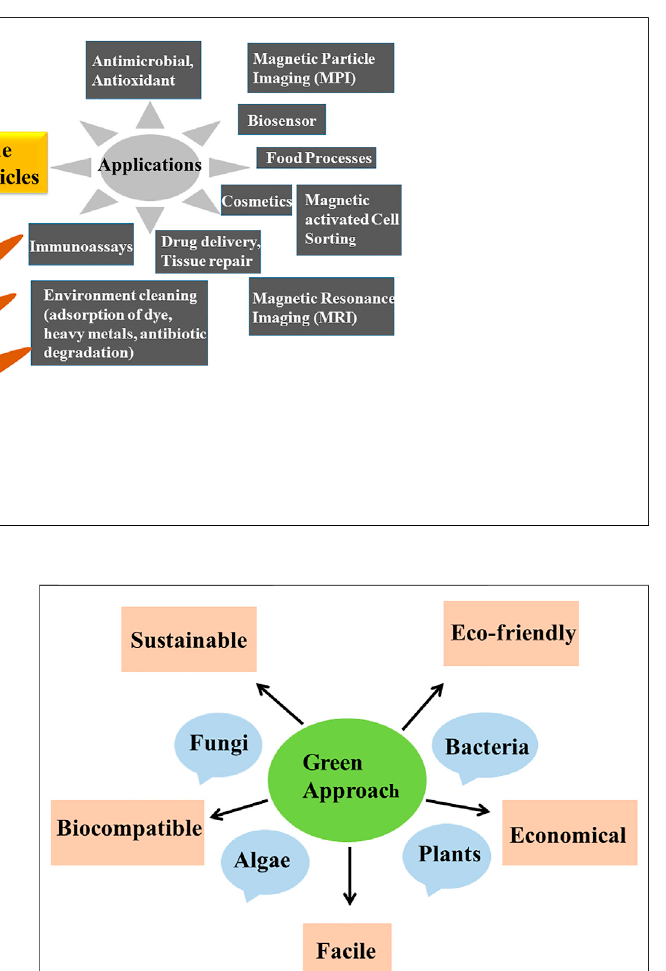
Frontiers in Nanotechnology |